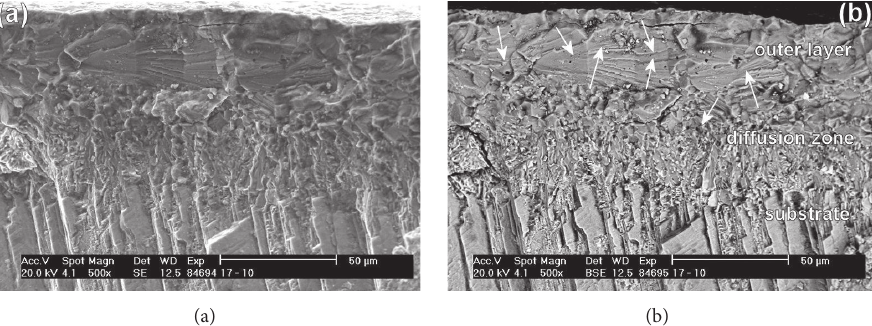
Figure 4: Initiation site in specimen with aluminide DC subjected to combined bending-torsion loading ( 𝑍 = 0.58 , 𝑁 𝑓 = 6.0 × 10 4 cycles) using (a) secondary (SE) and (b) back-scattered electrons